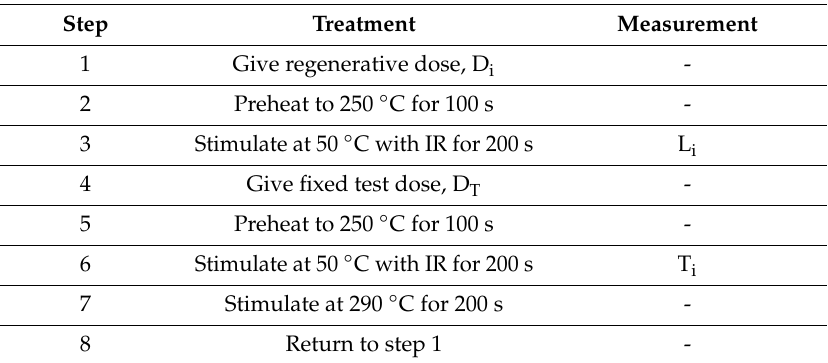
Table 2. OSL analysis measurement